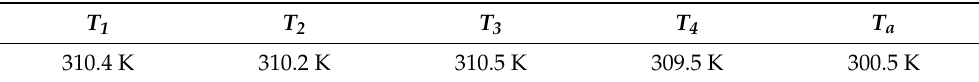
Figure 7. Temperature T 3 trend during thermal characterization test. Table 3. Steady state temperature test 20 A.